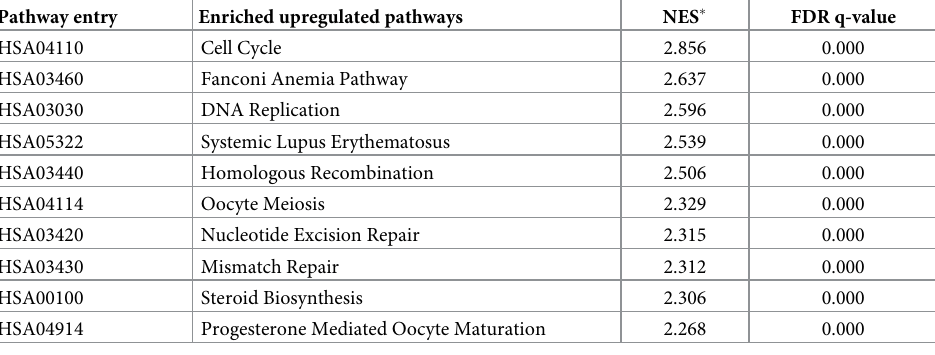
Table 2. Top 10 most significantly enriched upregulated pathways in HT29-MTX-E12 cells induced by SWMS conditions. Pathway